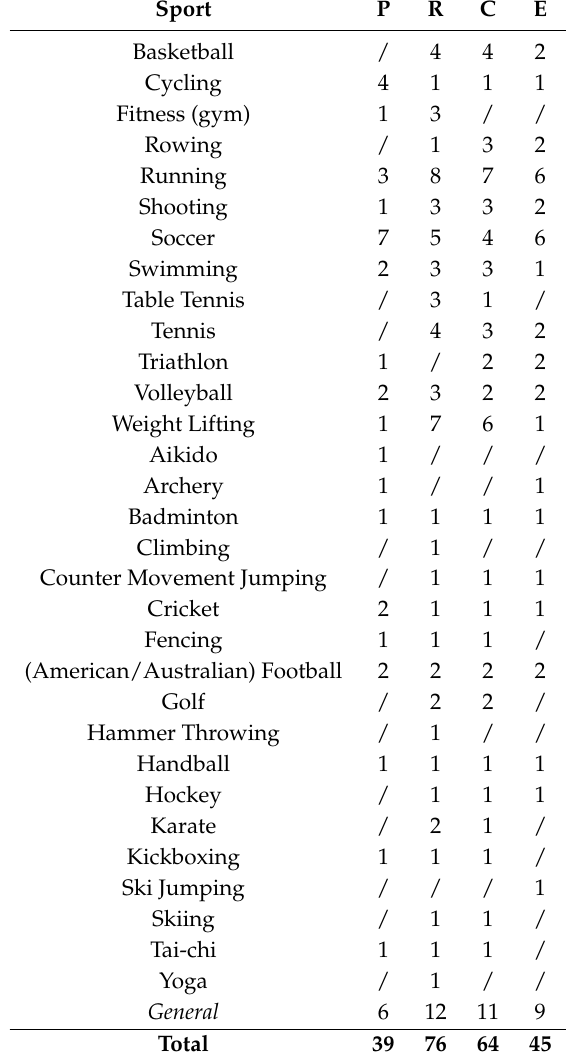
Table 20. Count of how many times individual training stages were researched.